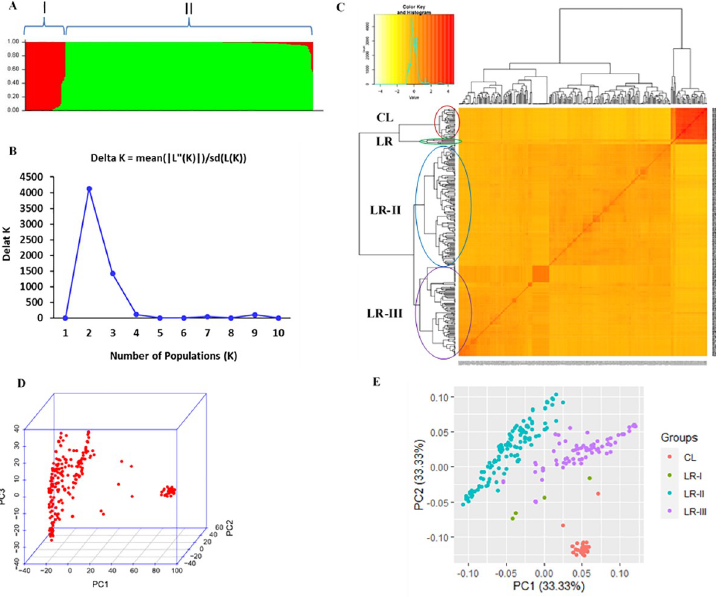
Fig 5. Population structure and relatedness among the 293 accessions used for the GWAS. A) population structure plot as reveled by STRUCTURE analysis. B) Delta K plot from STRUCTRUE HARVESTER analysis. C) 293x293 Kinship matrix plot using genetic similarity matching where outside the matrix is a clustering tree of the panel in to 2 main groups (in global view) while a bit of detailed view gave four clusters: CL = Cultivars and three Land Races sub- groups (LR-I, LR-II and LR-III). At the top left corner of the plot is the distribution of estimated kinship values. D) 3D PCA plot of the first three principal components where improved varieties still stood out in a distinct group at the very right end in the plot while the rest grouped in a similar way to the Kinship plot. E) 2D PCA plot elaborating sub- groups along with the variation explained by the components.